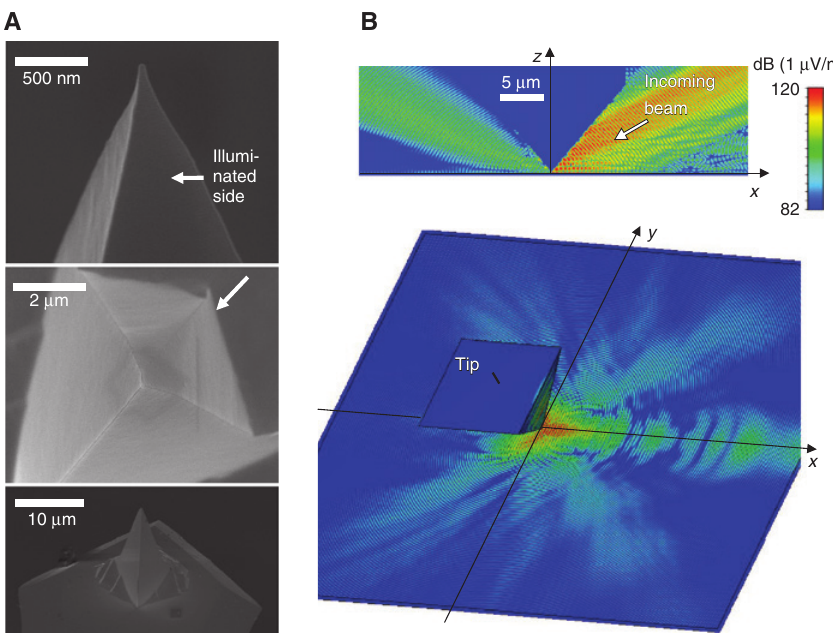
Figure 3: Shape of the probe tip and simulated field distribution (CST